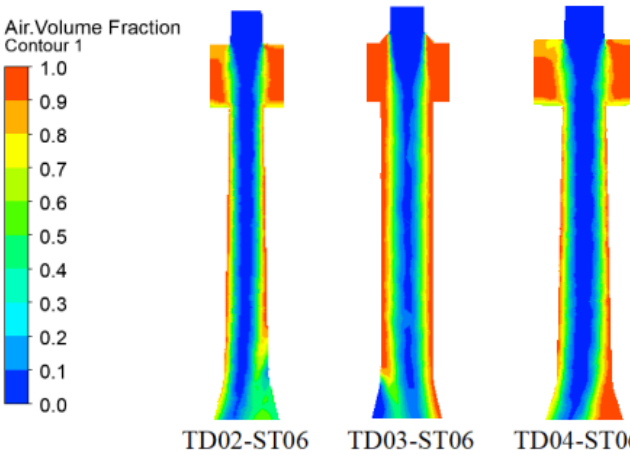
Figure 10. Contour of the air volume fraction at the throat region.